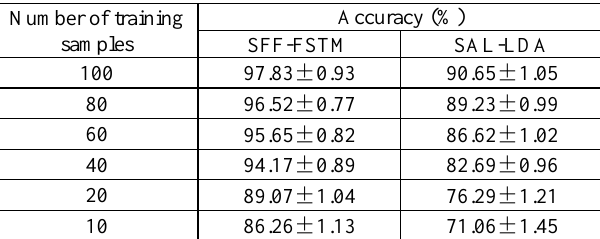
Table 6. Performance of SFF-FSTM and SAL-LDA for the Google dataset of SIRI-WHU with limited training samples